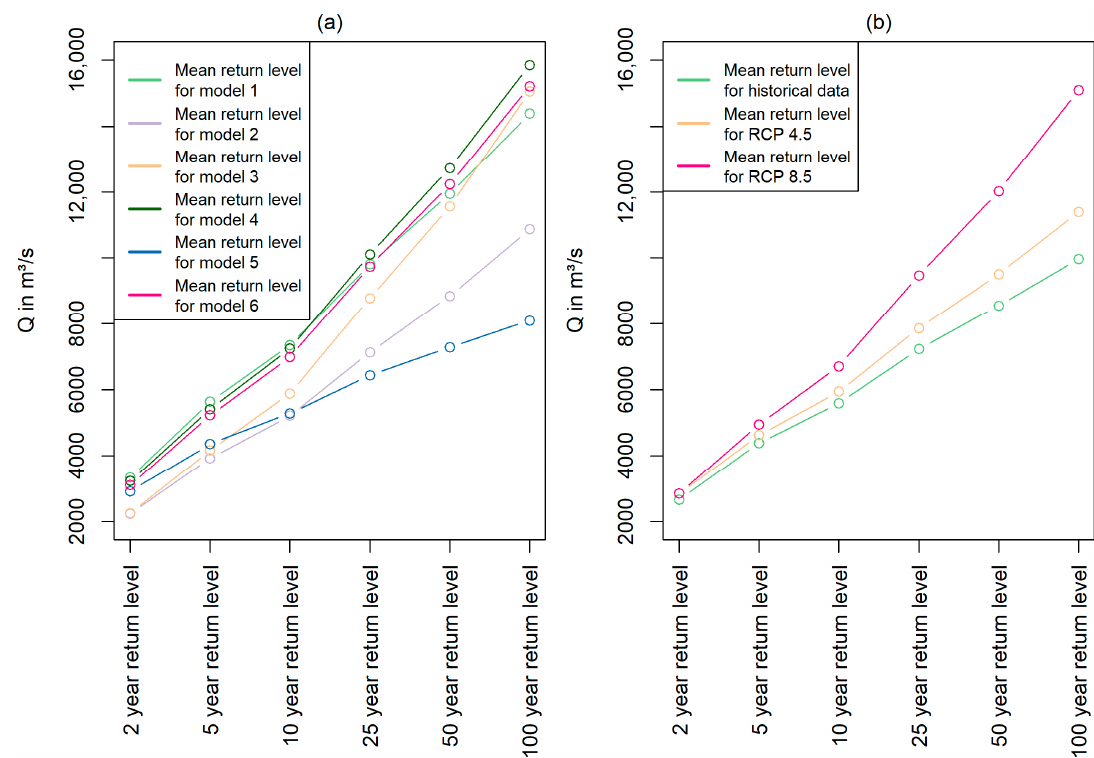
Figure 11. Arithmetic mean for each model across the two RCP scenarios for the return levels of discharge at the outlet ( a ) and arithmetic mean for each scenario across all six models for the return levels of discharge at the outlet ( b ).